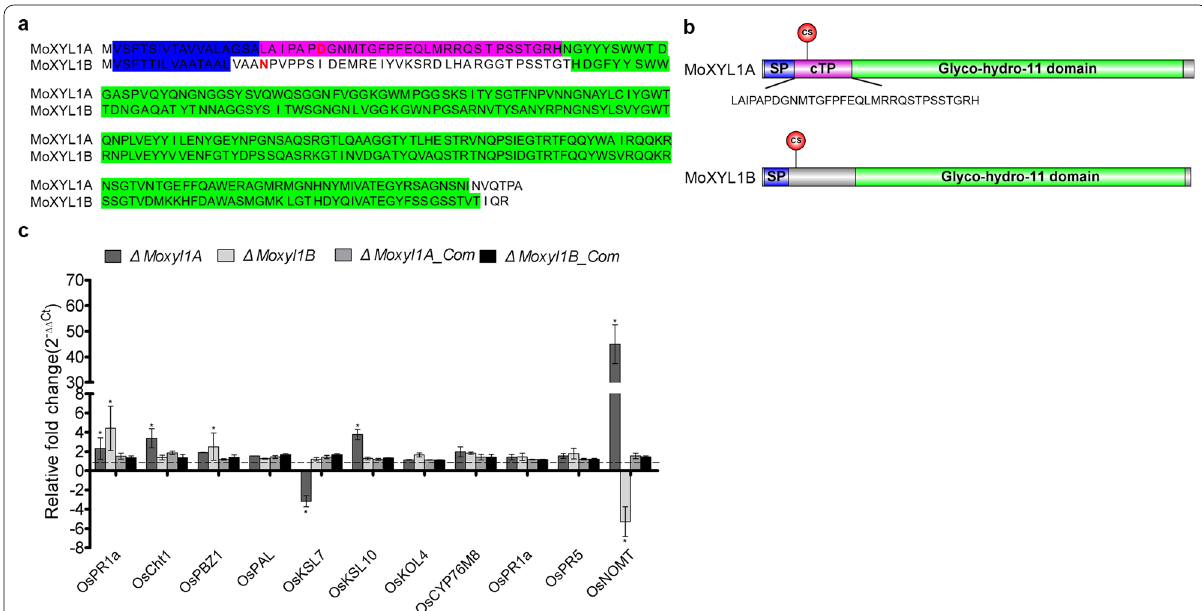
Fig. 6 Comparative sequence features of M. oryzae XYL1s and expression dynamics for pathogenicity-related genes in rice seedlings inoculated with strains lacking MoXYL1s. a and b Comparative alignment results for MoXYL1A and MoXYL1B and detail sequence architecture for MoXYL1A and MoXYL1B. Sequences shaded in Blue denote the secretion signal peptides (SP), sequences shaded in Red denote the chloroplast targeting peptide (cTP), sequences shaded in Green denote the conserved Glyco-hydro_11 domain motif, and the cleavage site is denoted as (CS) c Showed the relative expression (in folds) of genes coding for pathogenicity-related proteins in rice blast susceptible CO39 cultivar inoculated with Δ Moxyl1A, Δ Moxyl1B, Δ Moxyl1A_Com., Δ Moxyl1B_Com., and the wild-type at 12-hpi. Error bars represent standard deviation (SD). SD was calculated from three independent biological replicates along with three technical replicates. (*, P < 0.05 by